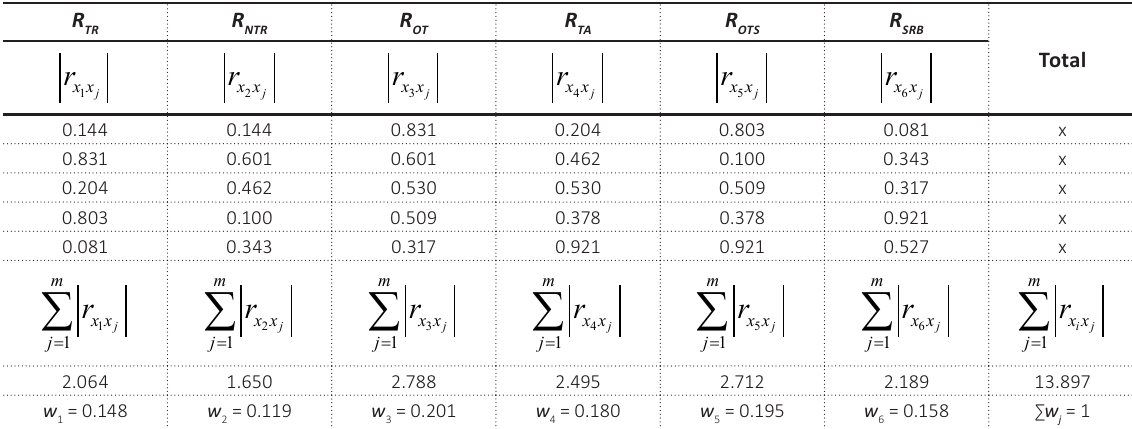
Source: Authors’ calculations.